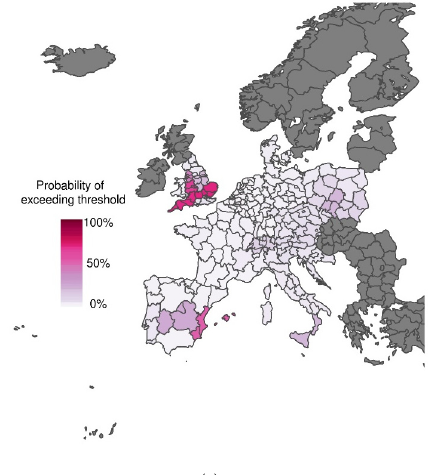
Figure 2. Probabilistic maps of exceeding emergency daily mortality threshold (75th percentile of daily mortality distribution in the warm tail) during the heat wave scenario (1–15 August 2003) using sub-seasonal forecasts of apparent temperature at lead times of ( a ) 1 day; ( b ) 4 days; ( c ) 8 days; ( d ) 11 days; ( e ) 15 days; ( f ) 18 days. The graduated colour bar represents the probability of exceeding the mortality threshold (ranging from 0%, pale colours, to 100%, deep colours).